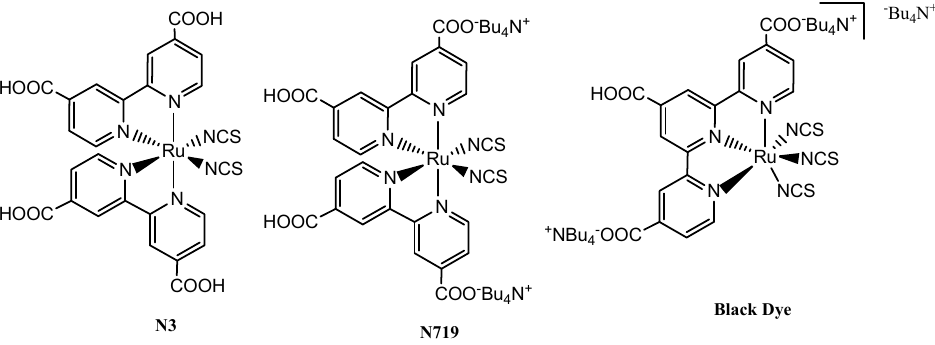
Figure 1. Structures for benchmark sensitizers N3 , N719 , and BlackDye for DSSC applications.